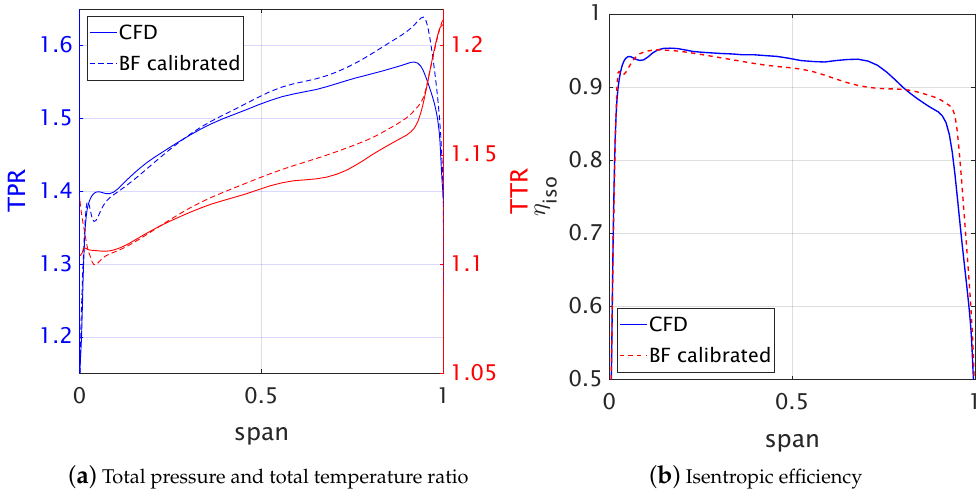
Figure 16. Spanwise profiles downstream of rotor blade at near-stall for reference CFD solution and calibrated